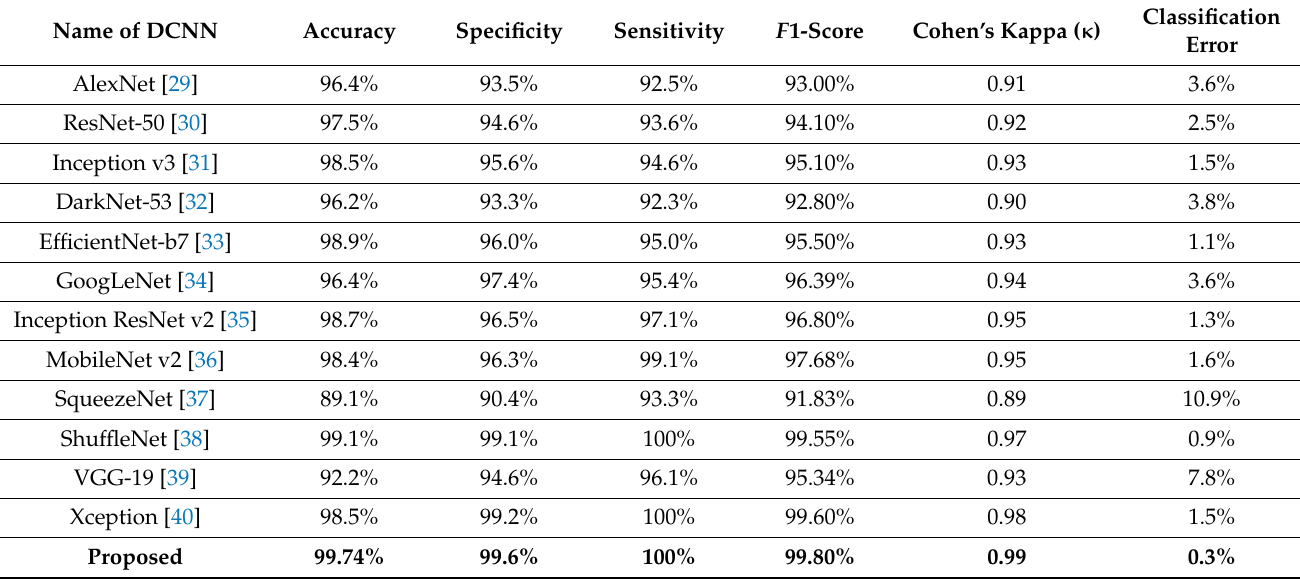
Table 2. Testing performance of different DCNNs for the chest X-ray dataset.